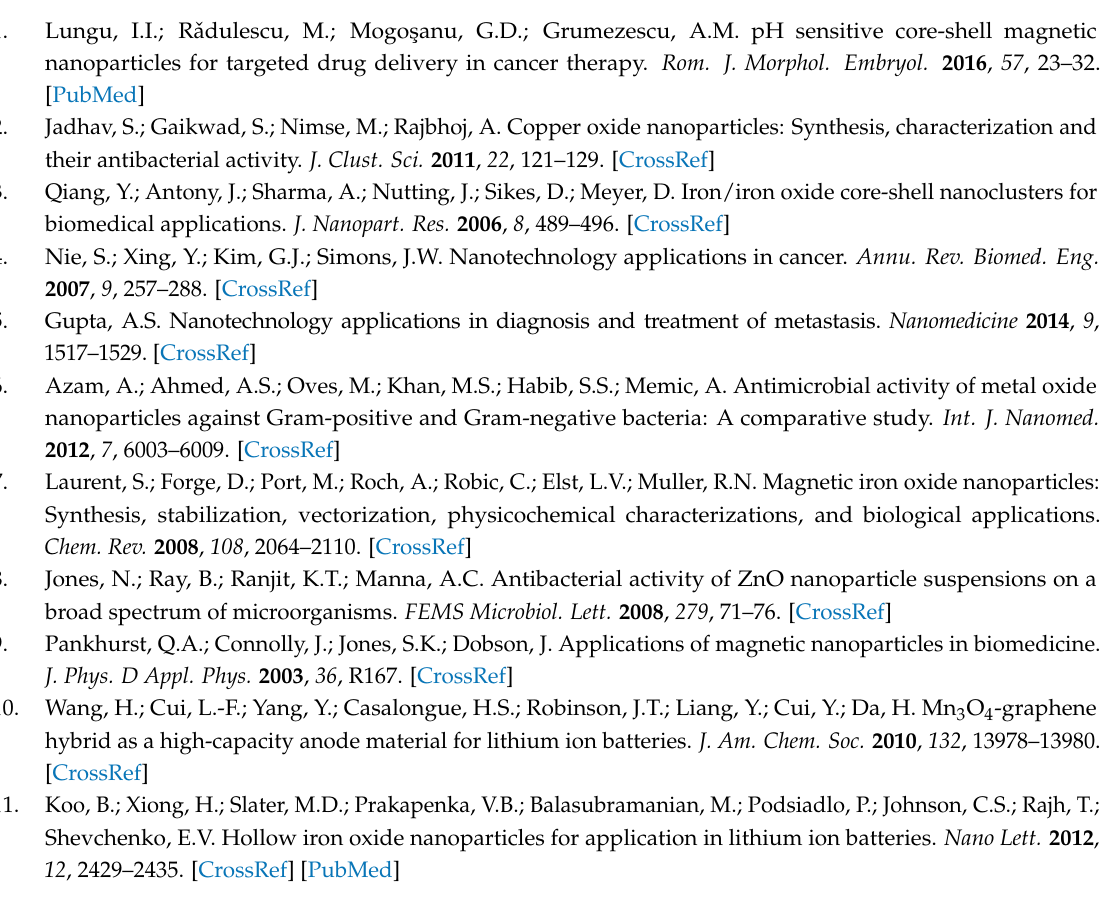
s1. Figure S1: (Color online) ( a ) Upper panel: average TM–TM distance (green), Co–Co distance (blue) and average Co–Ni distance (red) for Co 2 Ni 1 O m oxides as a function of the number of oxygen atoms, m. ( b ) Lower panel: average TM–O distance (green), average Co-O distance (blue),and average Ni-O distance (red) for Co 2 Ni 1 O m oxides as a function of the number of oxygen atoms, m. Continuous (dashed) lines correspond to average distances between oxygens on bridge (top) positions and TM atoms. Figure S2: (Color online) Binding energies in eV ( upper panel ) and average electronic charge transfer in e ( lower panel ) of A 4 − x B x O 6 (A, B = Fe, Co, Ni; x = 0 − 4) oxides. Blue, green and red curves correspond to Fe–Co, Fe–Ni and Co–Ni nanoalloys,